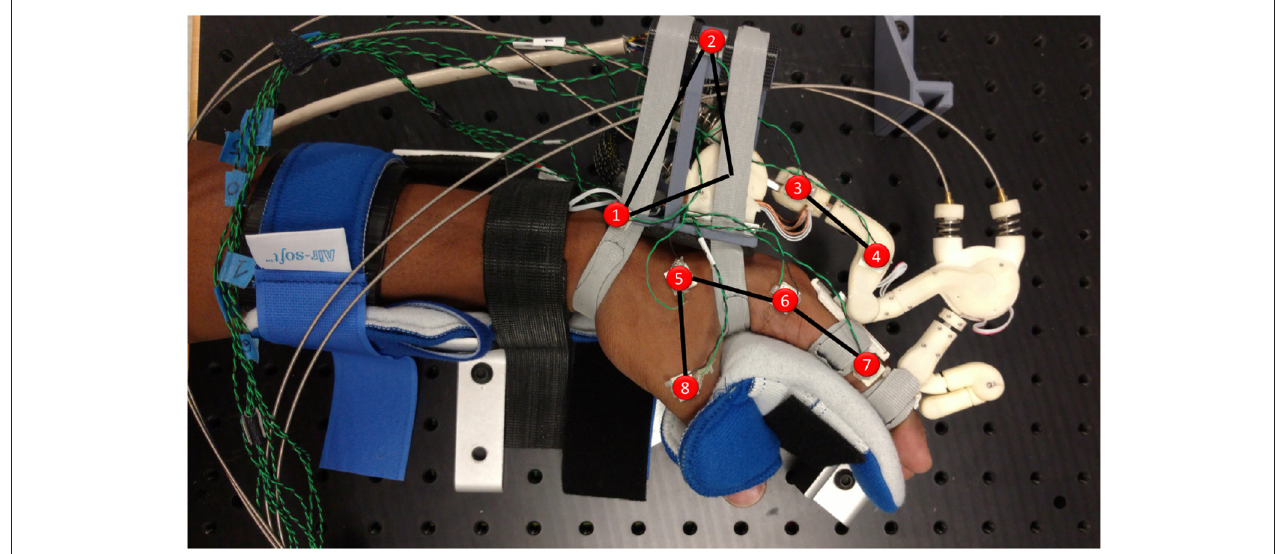
FIGURE 6 | Experimental setup for comparison to the simulated system. The human hand is held in a commercial brace reinforced and bolted down with aluminum channels (seen between the fingers and the thumb on the palmar surface of the hand). The Maestro hand exoskeleton is affixed with a modified base (link 1–2) that allows calibrated pre-tensioning of both straps. The Motion capture sensors are highlighted in